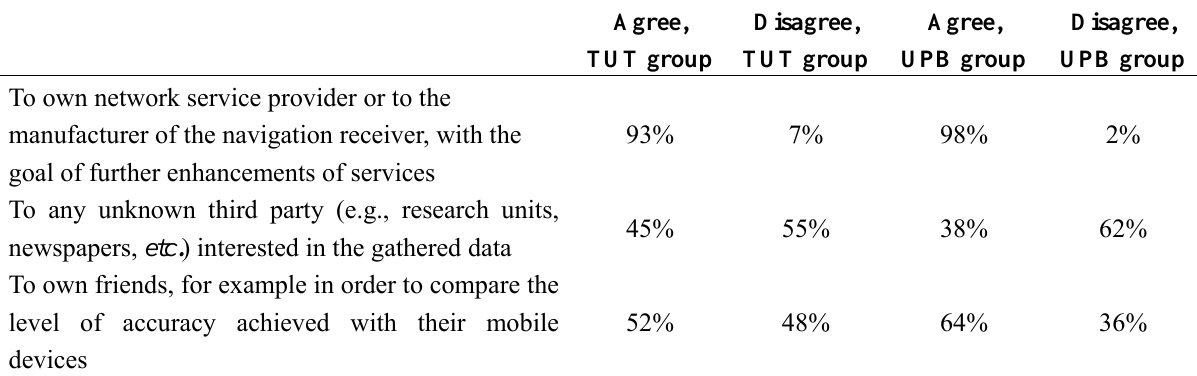
Table 3. Consent to use the user feedback related to the location estimation accuracy.